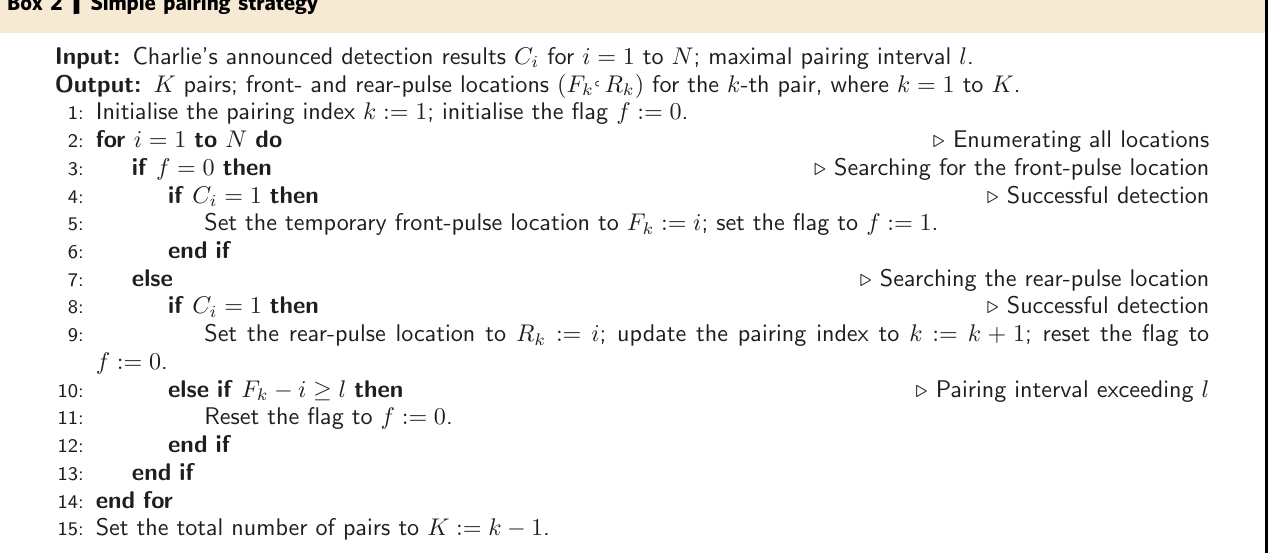
Box 2 | Simple pairing